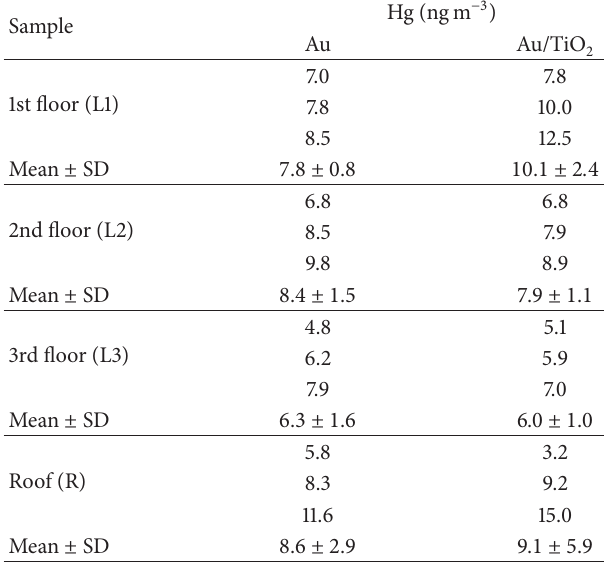
Table 4: TGM in the laboratory ambient air where “Au” stands for gold-coated